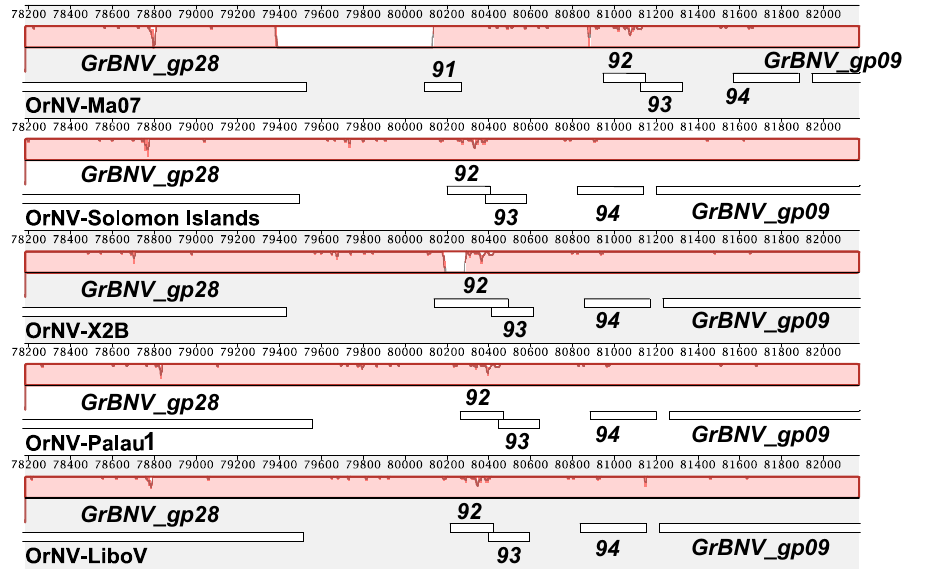
Figure 4. Mauve alignment of a region in OrNV genomes characterized by the deletion of a region containing OrNV-Ma07 ORF91. The numbering of ORFs in the OrNV-Ma07 genome is used to indicate ORFs that are conserved among isolates Ma07, Solomon Islands, X2B, Palau1, and LiboV. The gap in the block outline of the Locally Collinear Block (LCB) of Ma07 indicates the stretch of sequence in Ma07 which is not conserved in the alignment consensus sequence due to being missing from the other